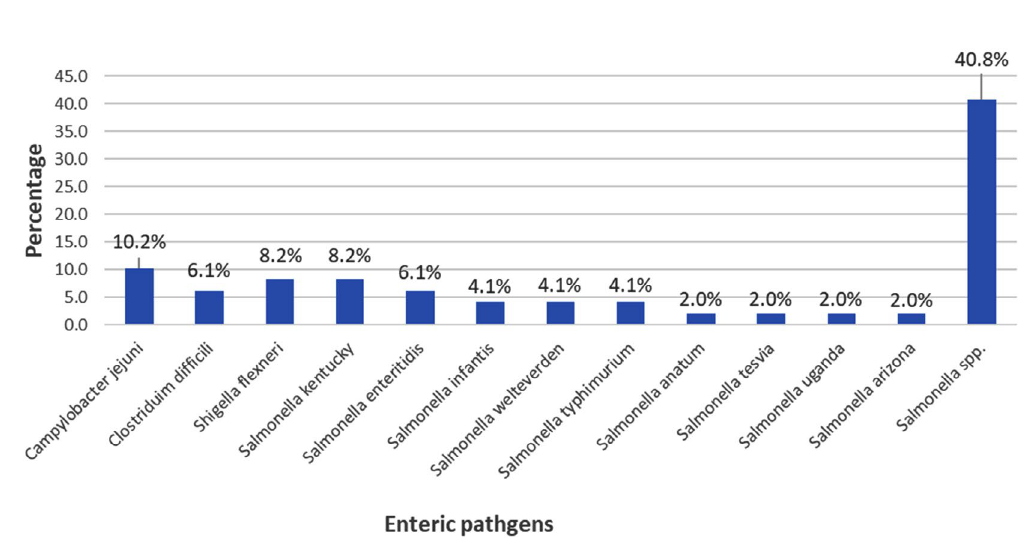
Fig. 1. Distribution of enteric pathogens detected inpatient attending